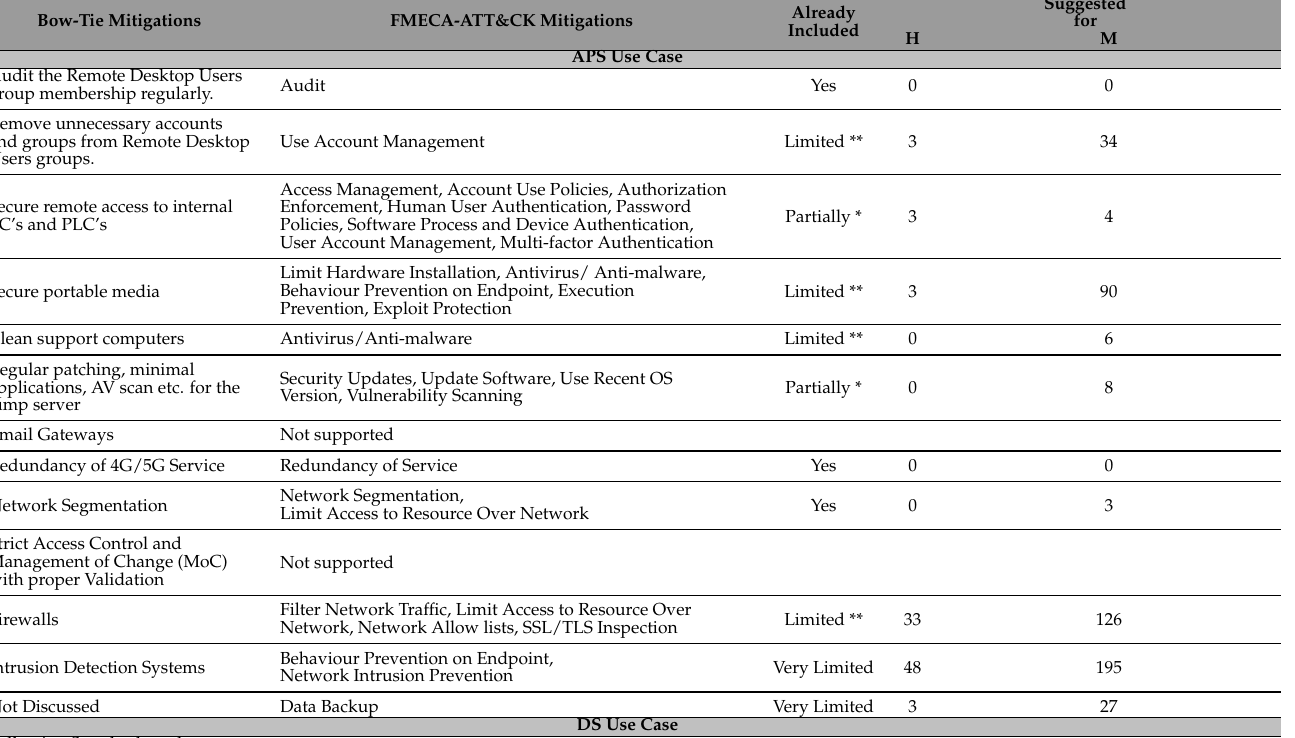
Table 5. The relations between the top controls identified through Bow-Tie and FMECA-ATT&CK. forBow-Tie Mitigations FMECA-ATT&CK